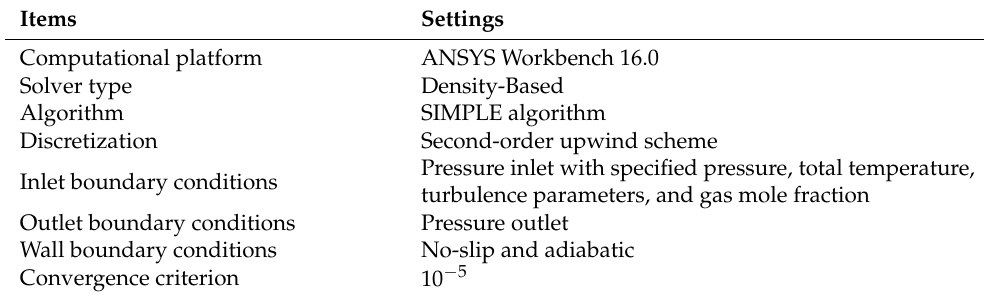
Figure 2. Flow chart of the calculation of simulation model. Table 1. Numerical schemes for this